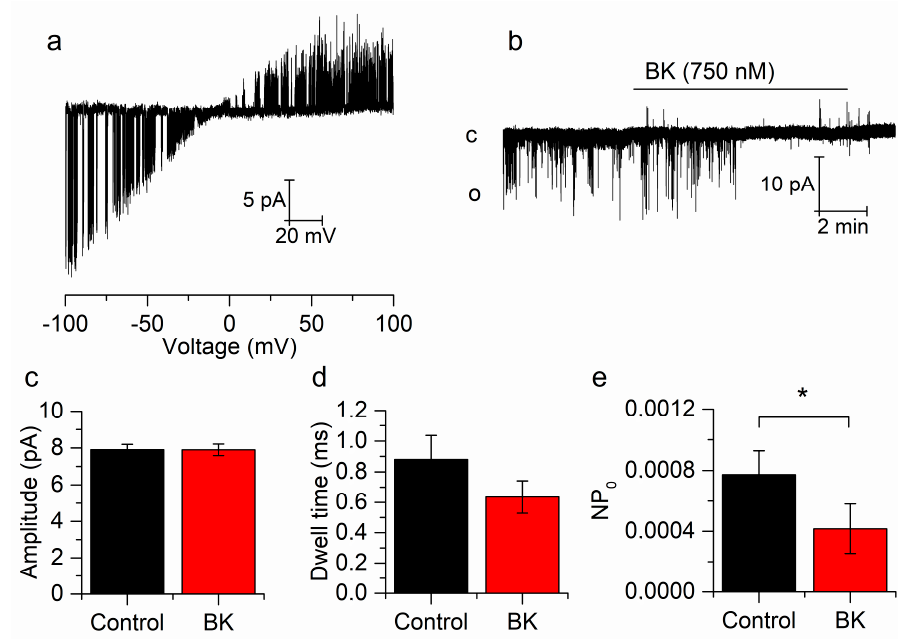
Figure 3. Bradykinin reduces the open probability of single TREK-2 channels. ( a ) Representative cell-attached, TREK-2 single-channel behavior in response to voltage ramps from − 100 to + 100 pA in mSCG neurons. ( b ) E ff ect of BK on a single TREK-2 channel voltage-clamped at − 60 mV. ( c – e ) BK reduces the open probability ( e ) without a ff ecting dwell time ( d ) or current amplitude ( c ). Recordings belong to the same patch. * p <